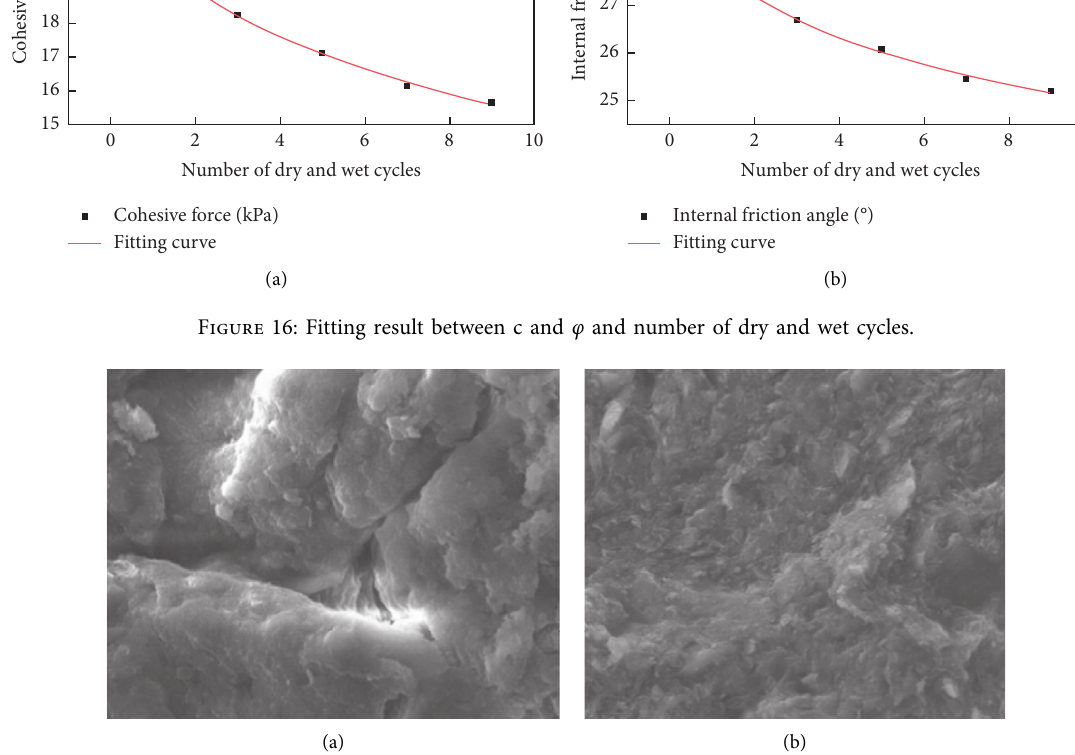
Figure 17: Microscopic images of natural and remolded red clay at 2000 × magnification. (a) Natural state. (b) Reshape state.